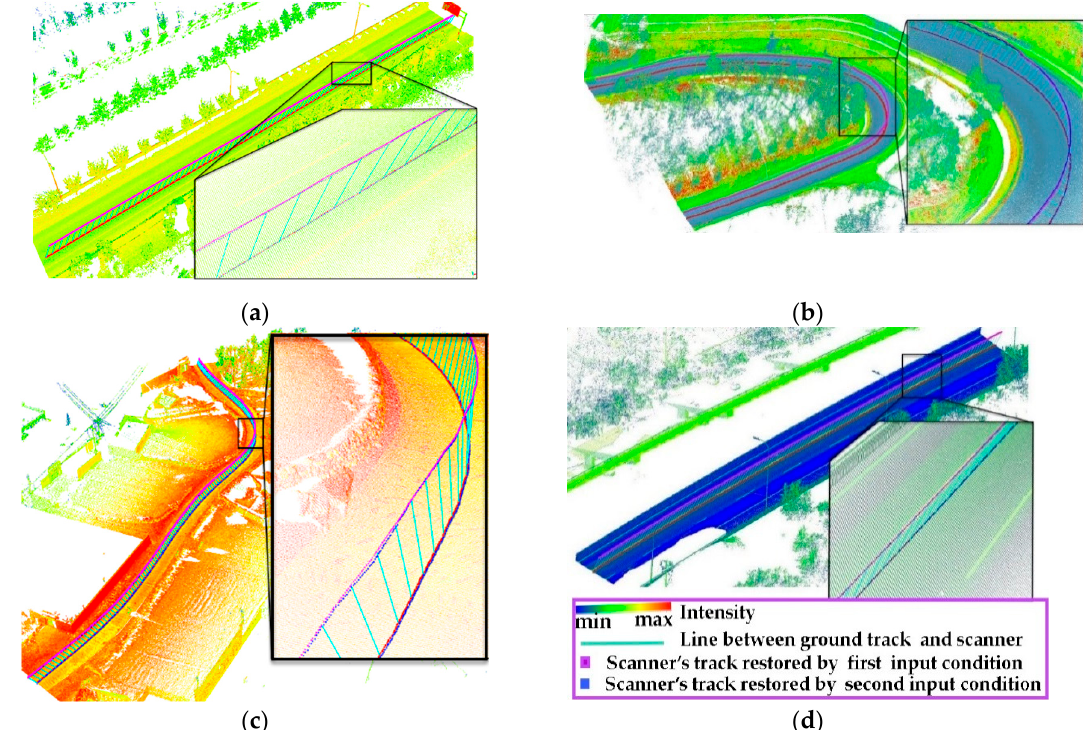
Figure 16. The recovered trajectory of scanner using di ff erent methods under two kinds of input